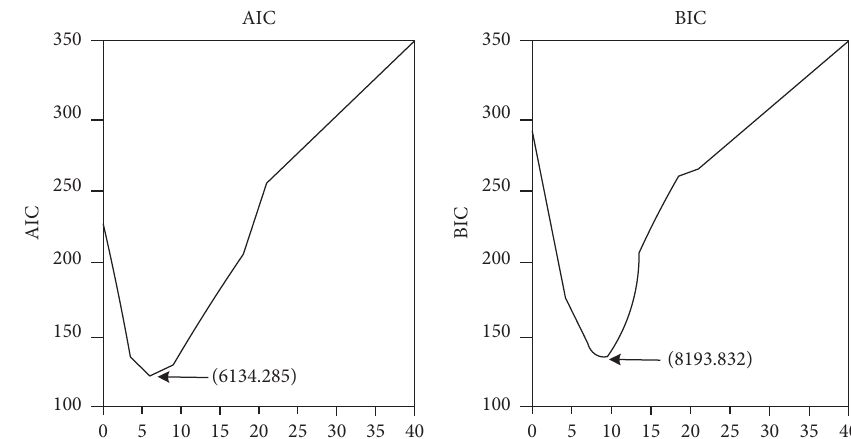
Figure 3: Graphic analysis of changes in AIC and BIC with lambda.